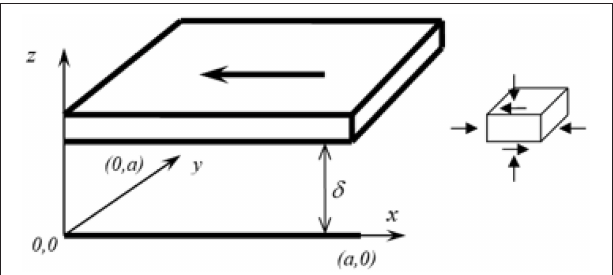
FIGURE 3 | Coordinate model of the flowing MRF between a